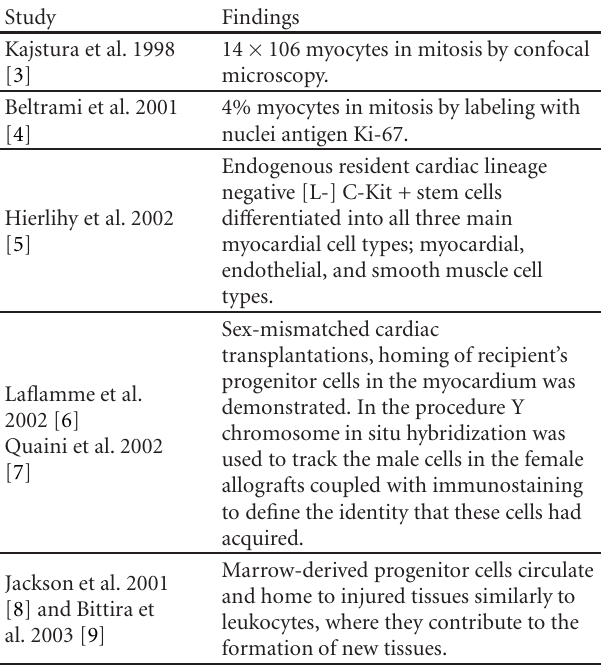
Table 1: Evidence of myocardial